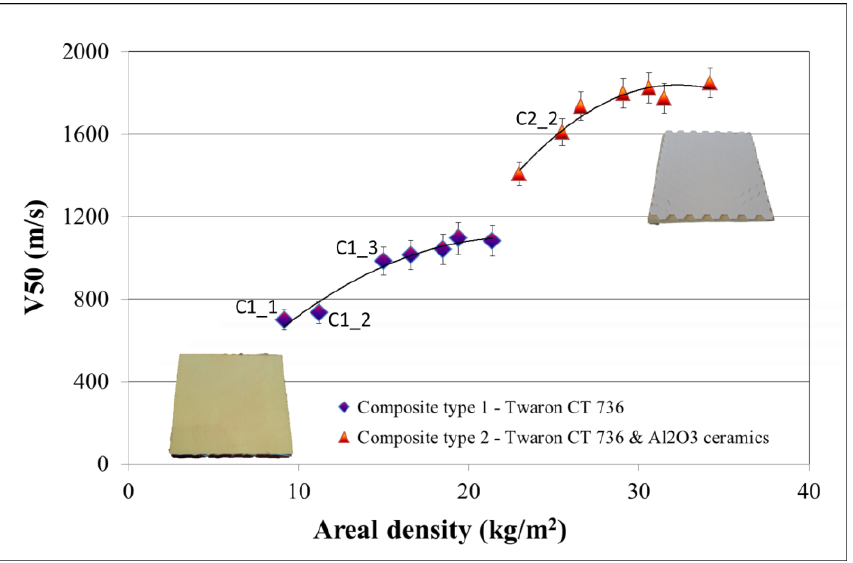
Figure 3. V50 ballistic protection limit by areal density of the tested composite system obtained for composites type 1 and 2.